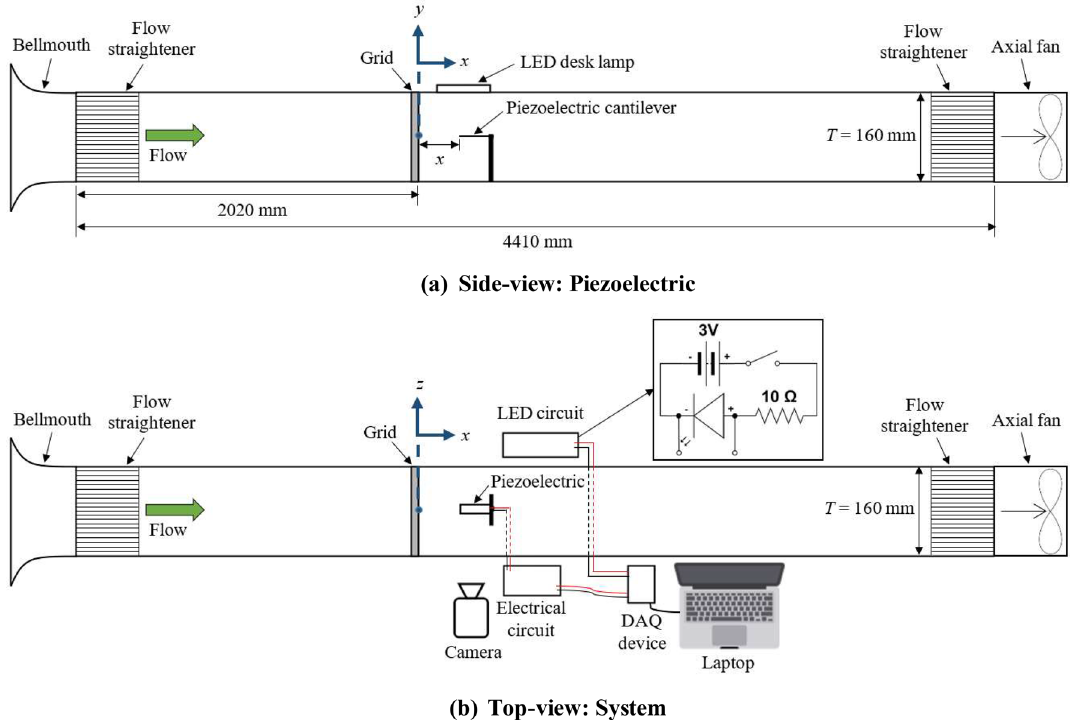
Figure 1. Schematic of experimental setup: ( a ) Side-view and ( b )